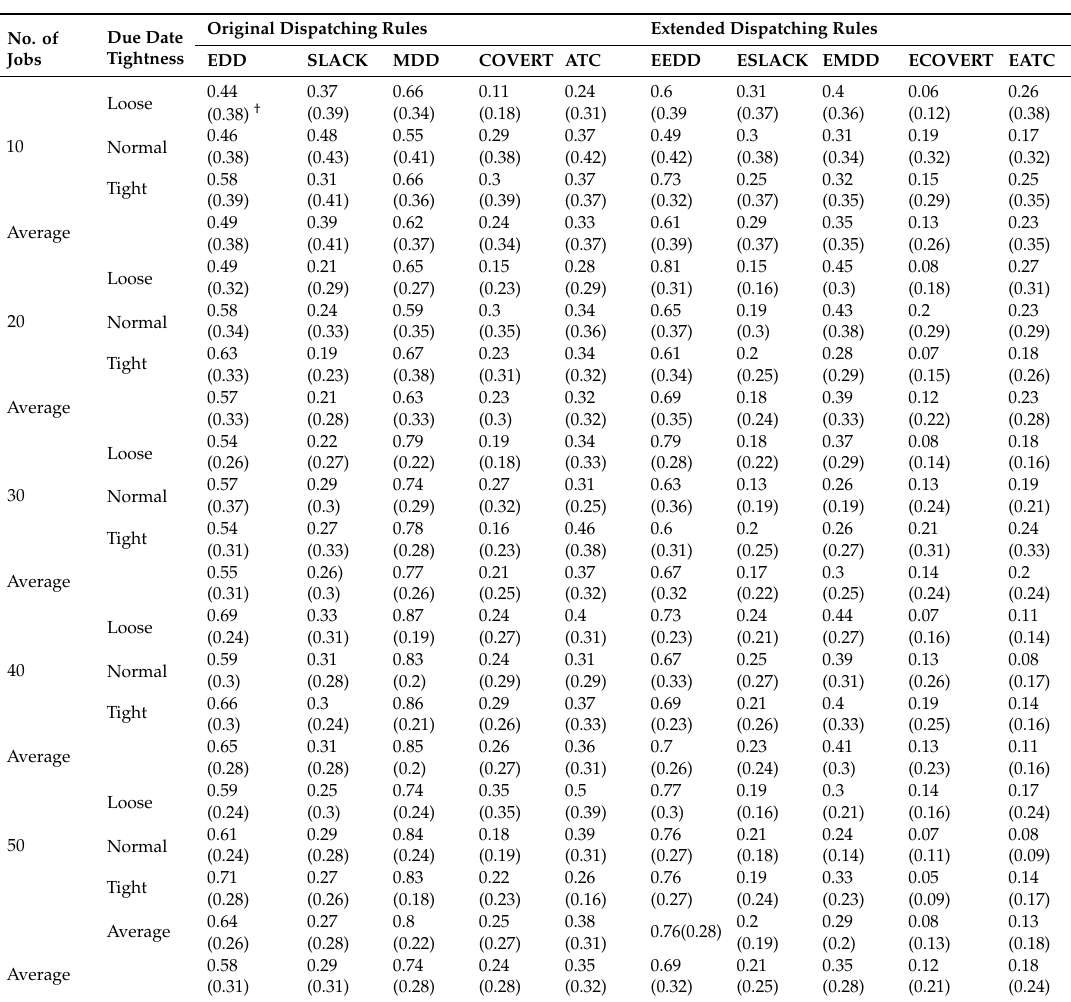
Table 1. Comparison of relative deviation index (RDI) values between five dispatching rules and their extended